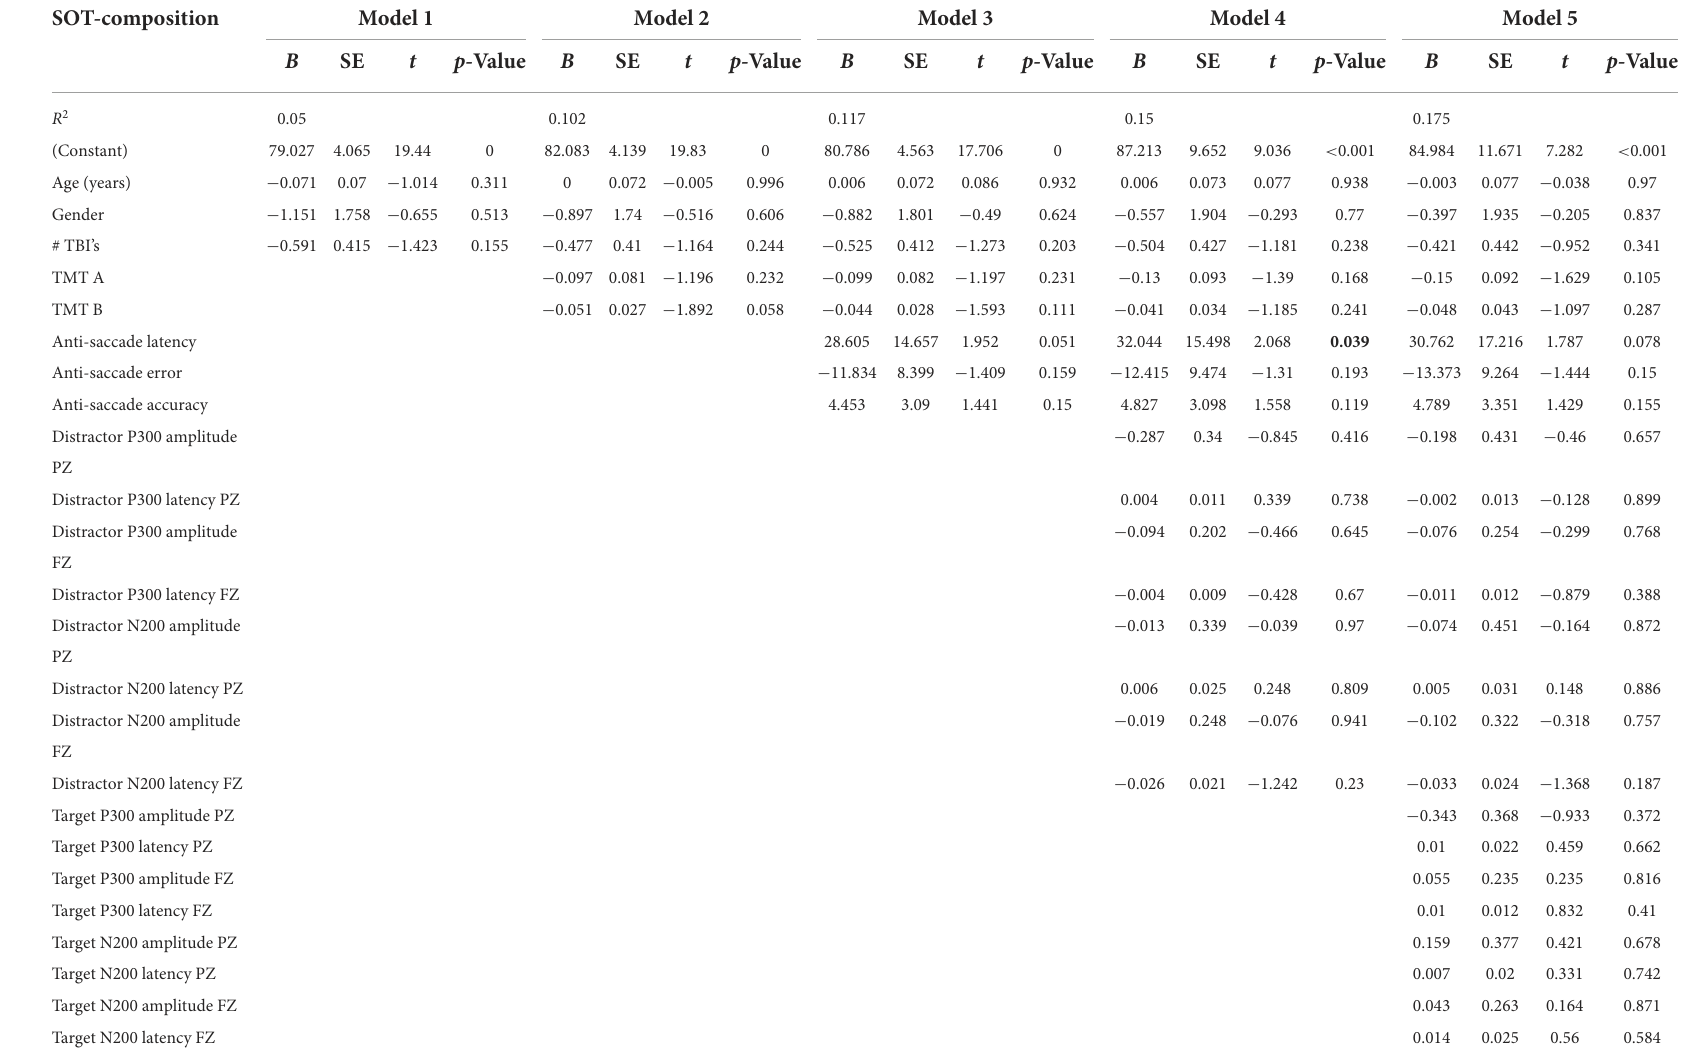
TABLE 2 Results from the hierarchical regression for SOT composite, averaged over the six SOT balance